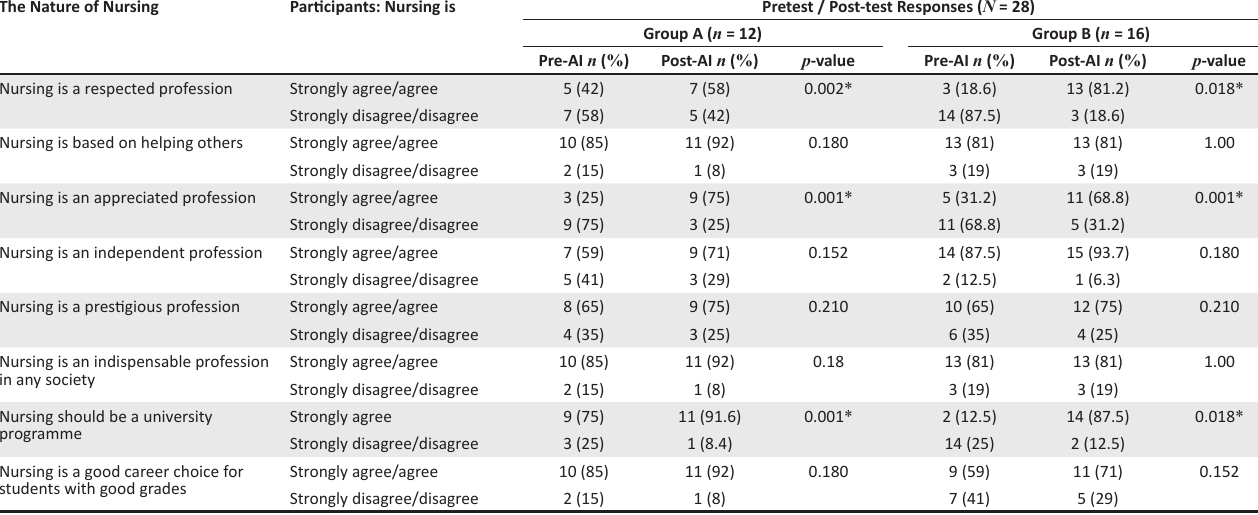
TABLE 2: Student nurses’ perceptions of nursing as a profession before and after AI. The Nature of